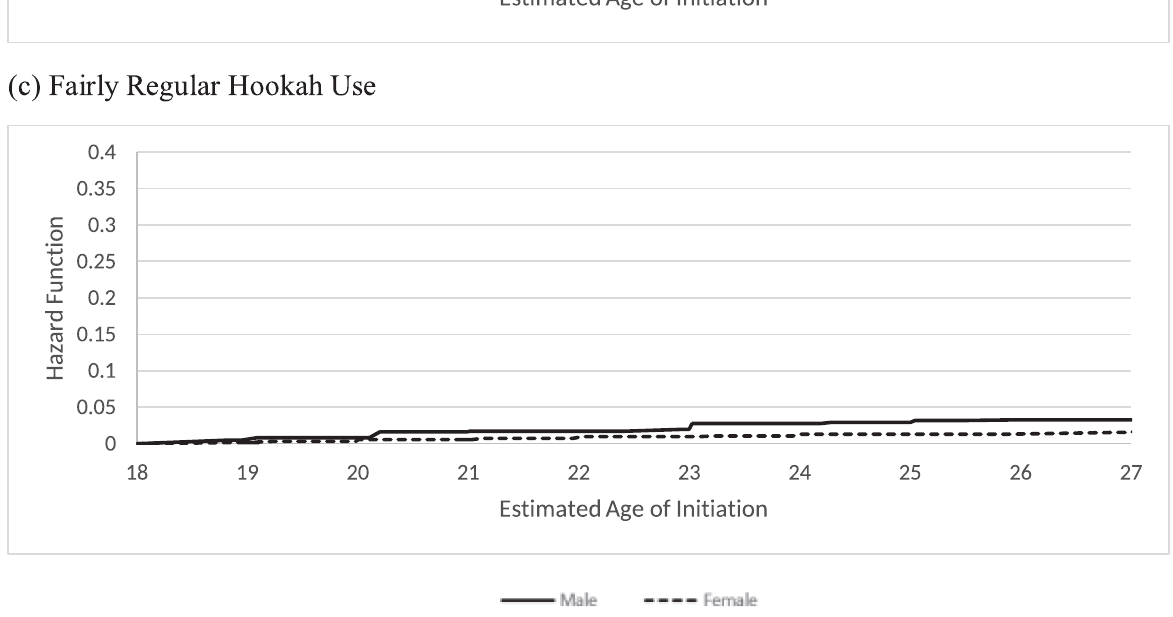
Fig 2. Estimated hazard function of the age of hookah initiation by sex. https://doi.org/10.1371/journal.pone.0258422.g002 PLOS ONE | https://doi.org/10.1371/journal.pone.0258422 October 12,